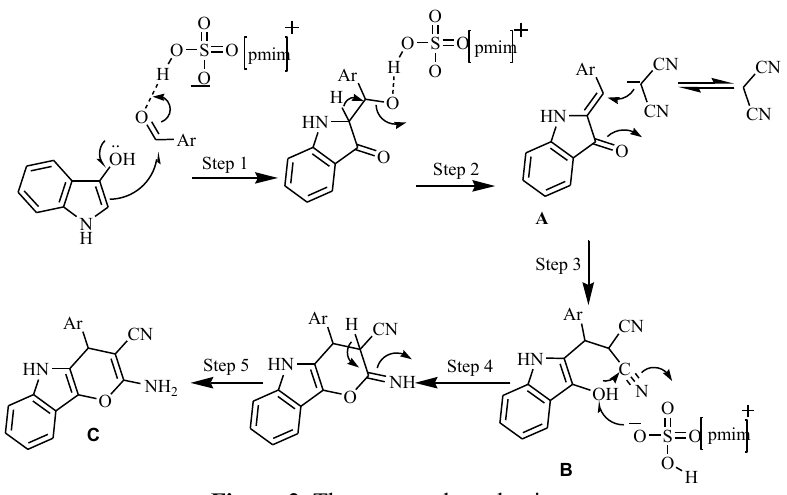
Figure 2. The proposed